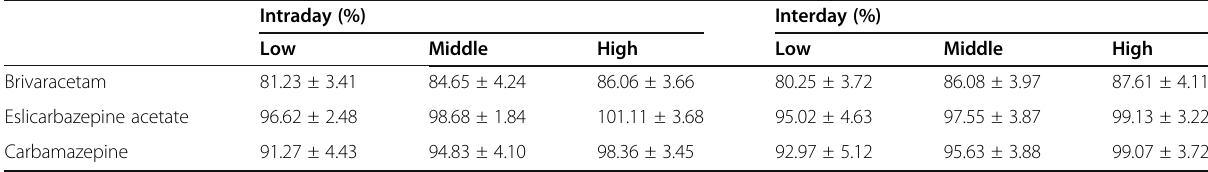
Table 2 Intraday and interday precision and accuracy values of analytes in the plasma